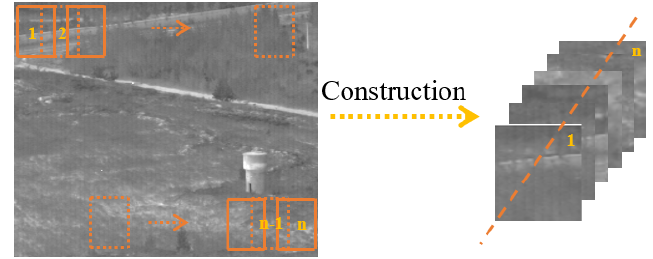
Figure 4. Traditional sliding window sampling